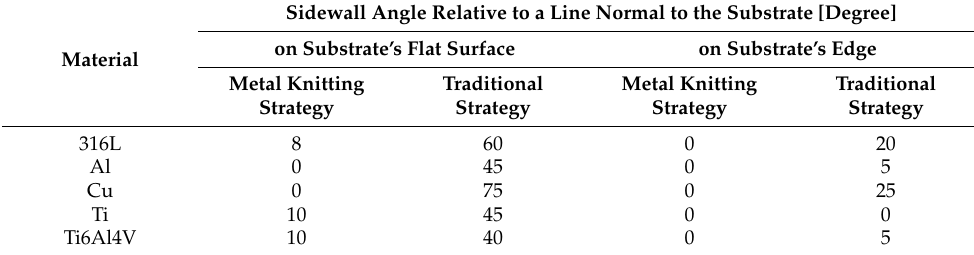
Figure 5. CSAM 316L growing from a substrate’s flat surface or from its edge. Table 3. Sidewall angles produced by traditional and Metal Knitting